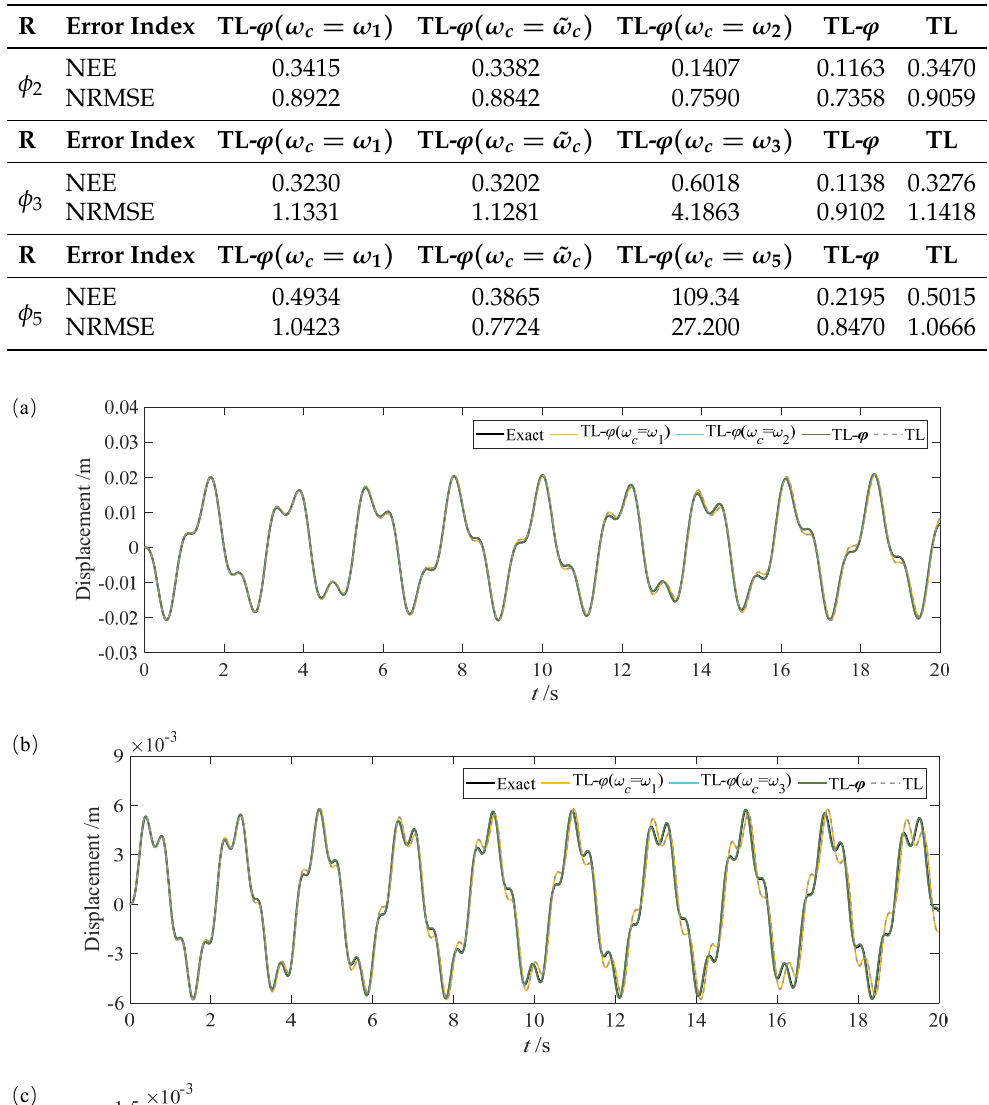
Table 13. Displacement errors of the 5th floor (G2).